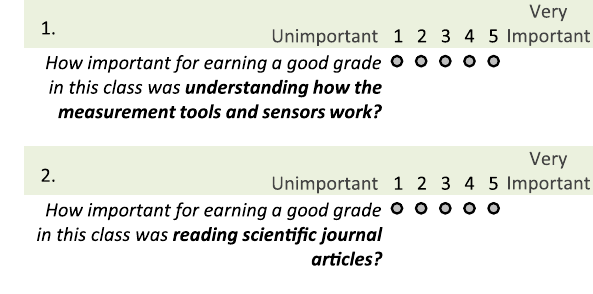
FIG. 2. Two expectations questions as they are presented to students in the postsemester E-CLASS online